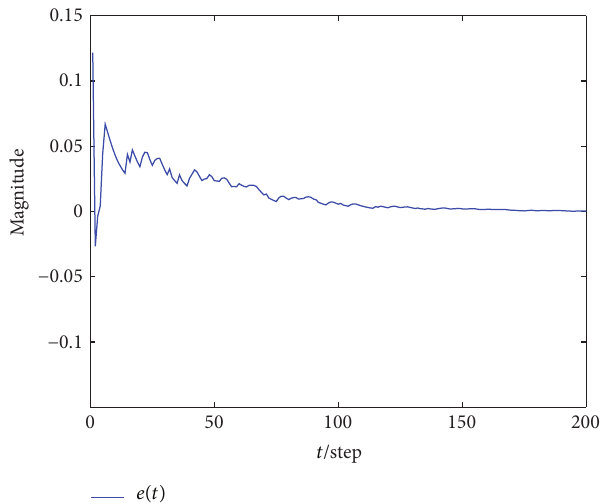
Figure 4: Filtering error response corresponding to uncertain parameters 𝜆 1 = 0.4 and 𝜆 2 = 0.6